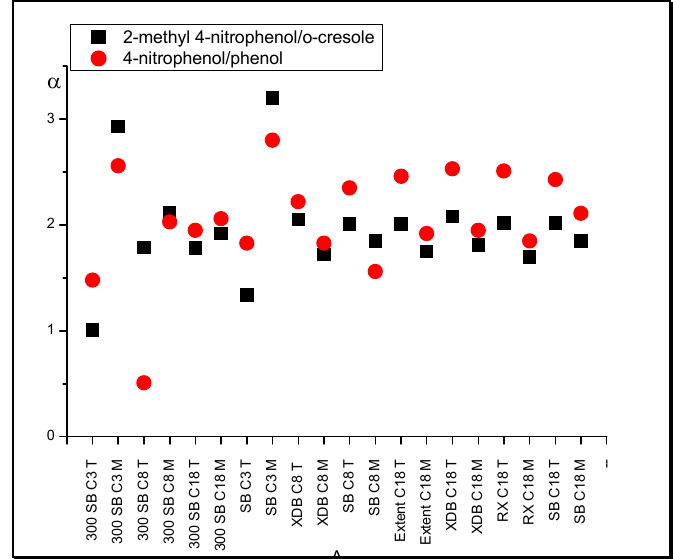
Figure 5. Separation factor, α , values of hydrocarbons with different functional groups in systems with different nonpolar stationary phases and methanol (M) in water and tetrahydrofuran (T) in water (modifier concentrations as in Table 1).